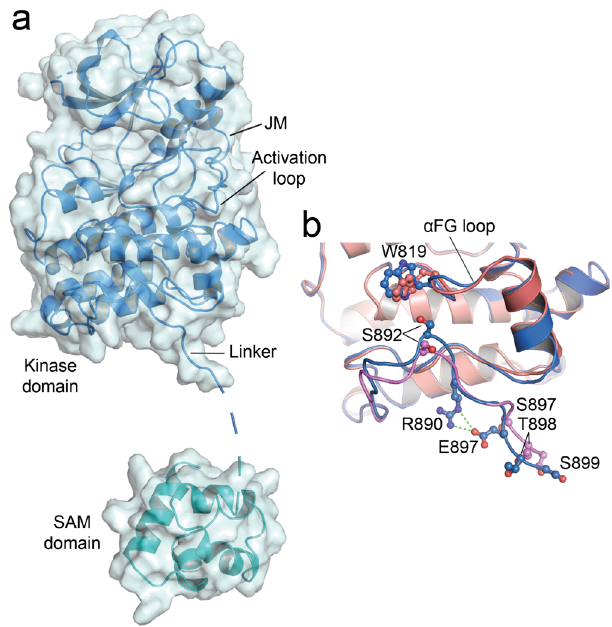
Fig. 2 Crystal structure of the intracellular region of the EphA2 S897E/ S901E phosphomimetic mutant. a Overview of the asymmetric unit containing a single EphA2 molecule in an elongated conformation; resolution 2.8 Å. The kinase domain is shown in blue and the SAM domain in cyan. The structure includes most of the juxtamembrane segment (JM) and the kinase domain, the full activation loop (including residues L760- I779, which are not de fi ned in the WT structure), and the SAM domain (residues V909-L965). Parts of the linker region and N-terminus of the SAM domain (residues 900 – 908, dashed line) and the C-terminal tail (K966-I976) are not visible in the structure due to missing electron density. b Comparison of the resolved linker regions in the structures of EphA2 WT molecule B (colored as in Fig. 1d) and the S897E/S901E mutant (blue), highlighting key differences in the linker structures. Key residues are shown as sticks and labeled. R890 and the phosphomimetic E897 in the S897E/ S901E structure form a salt bridge (green dashes). The SAM domains are omitted for